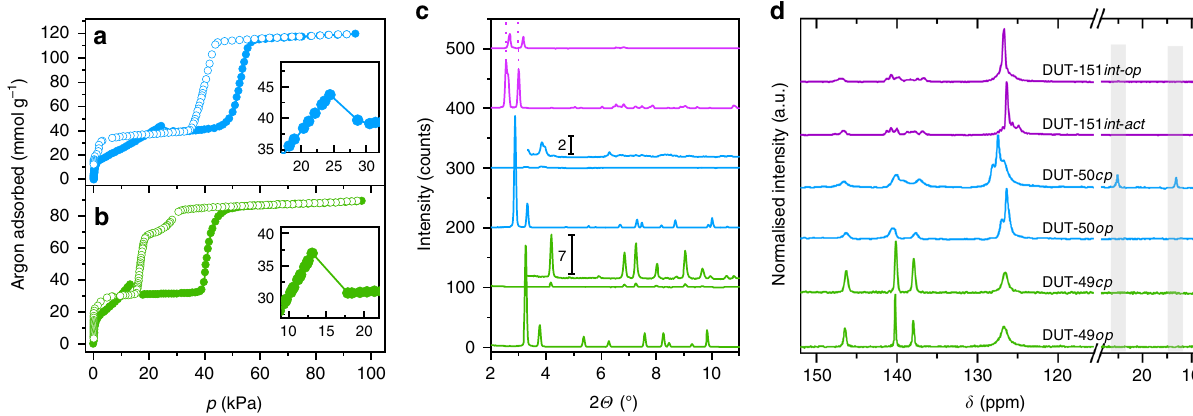
Fig. 4 Argon adsorption, in situ X-ray diffraction and NMR spectroscopy. a , b Argon adsorption ( fi lled circles) and desorption (open circles) isotherm at 87 K of DUT-50 ( a ) and DUT-49 ( b ), inset represents magni fi ed region of NGA. c X-ray diffraction patterns of evacuated (bottom) and n -butane loaded (top) samples at 273 K including magni fi cation (offset 100 counts). d 13 C CP MAS NMR spectra of argon- fi lled (bottom) and n -butane loaded (top) samples at 298 K, grey areas indicate peaks corresponding to n -butane. Colour code: DUT-49 (green), DUT-50 (blue), DUT-151 int